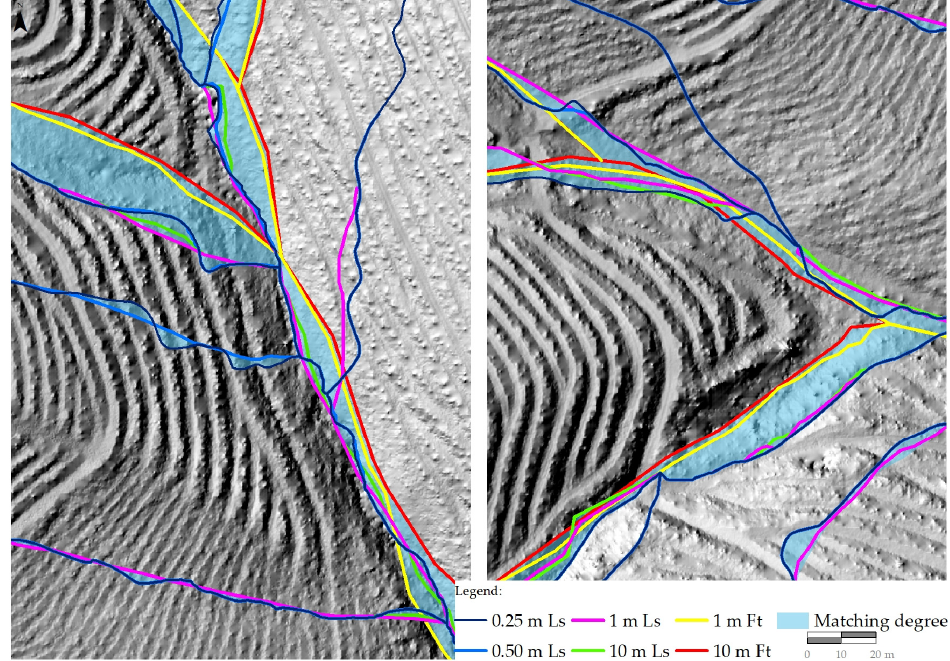
Figure 5. Matching degree of the extracted stream networks for the different DEMs considering the 0.25 m Ls DEM as a